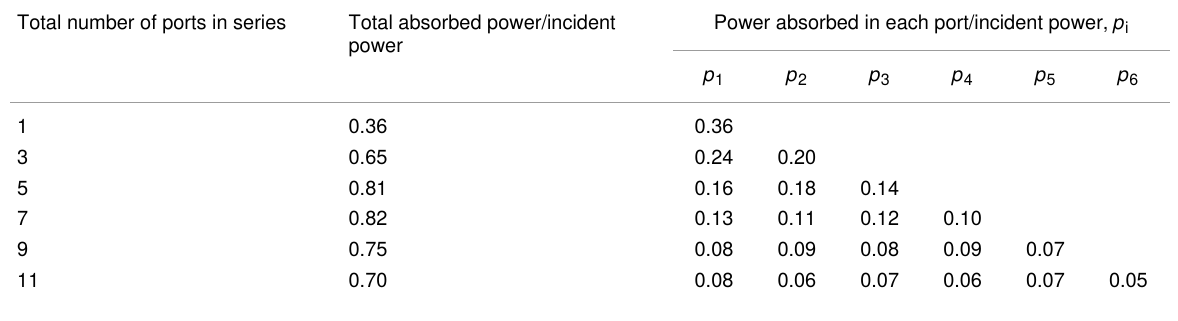
Table 1: Absorbed power for different configurations of JJs series integrated into the same log-periodic antenna. Total number of ports in series